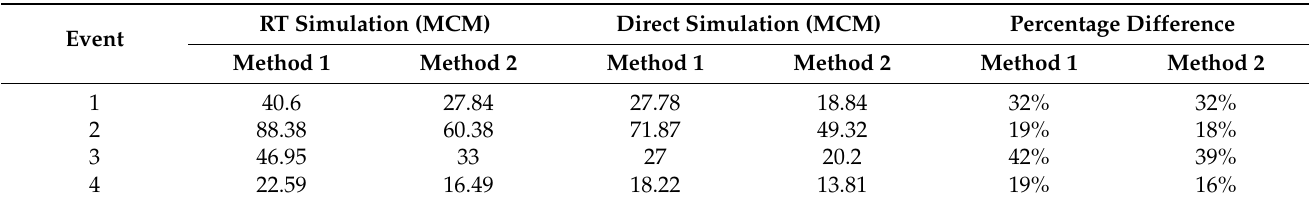
Table 5. Comparison of total RT calculated flow by different methods with direct simulation flow for each event of WASH123D (MCM: million cubic